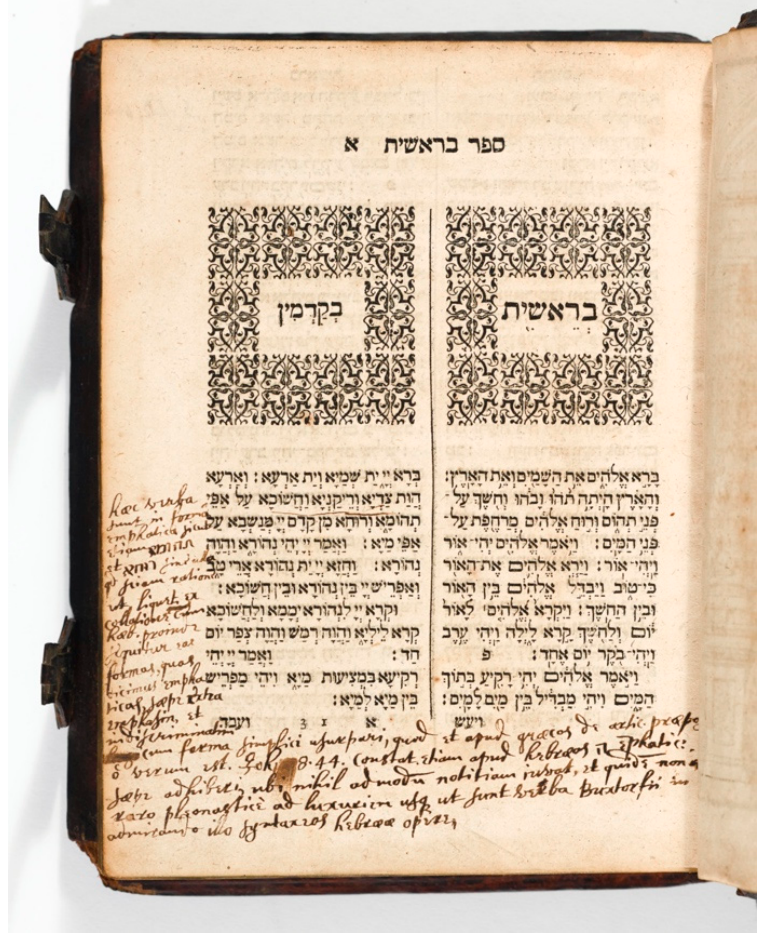
Figure 2. Torah in Hebrew, with Targum and Latin annotations; Marsh’s Library B.3.3.17.